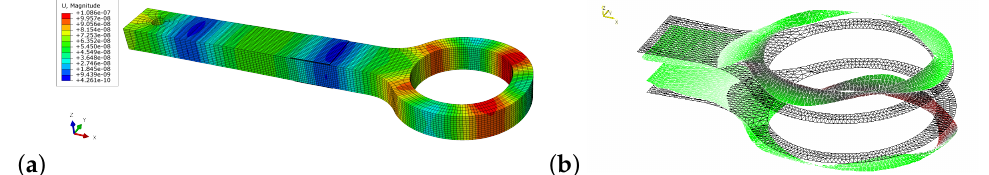
Figure 11. Comparison of in-plane radial vibration mode shape of pristine necked lug at ( a ) f FEM = 67,875 Hz for FEM and ( b ) f SLDV pristine